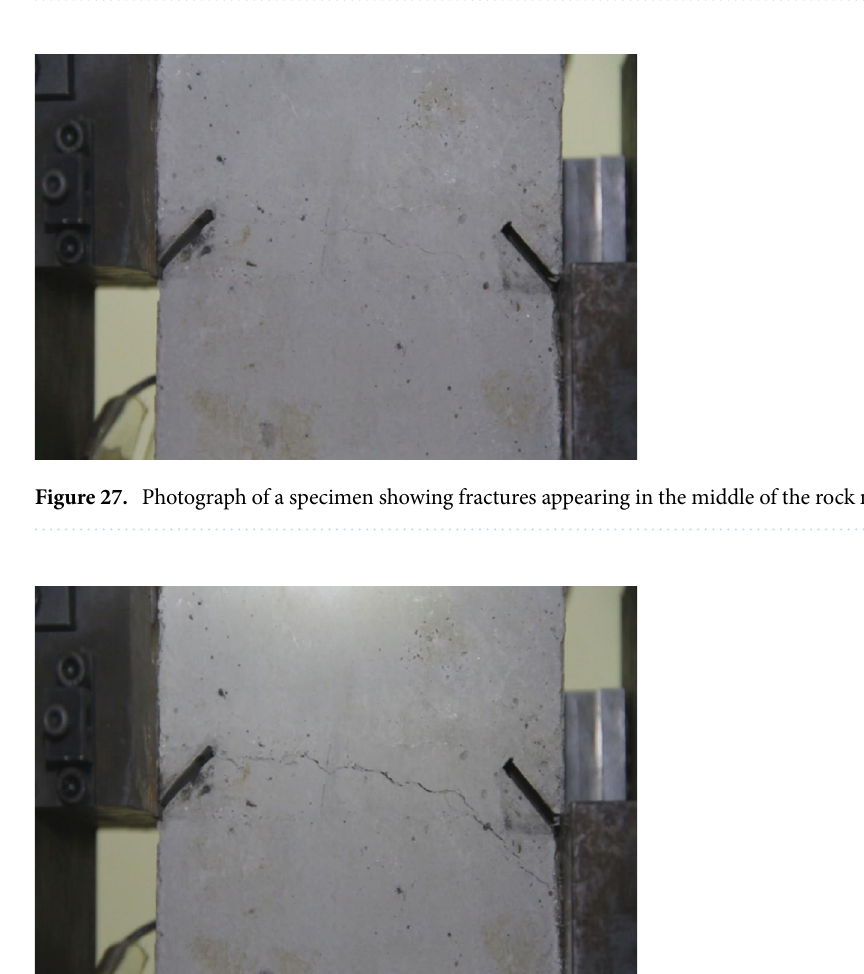
Figure 26. Photograph of a specimen showing fractures penetration.